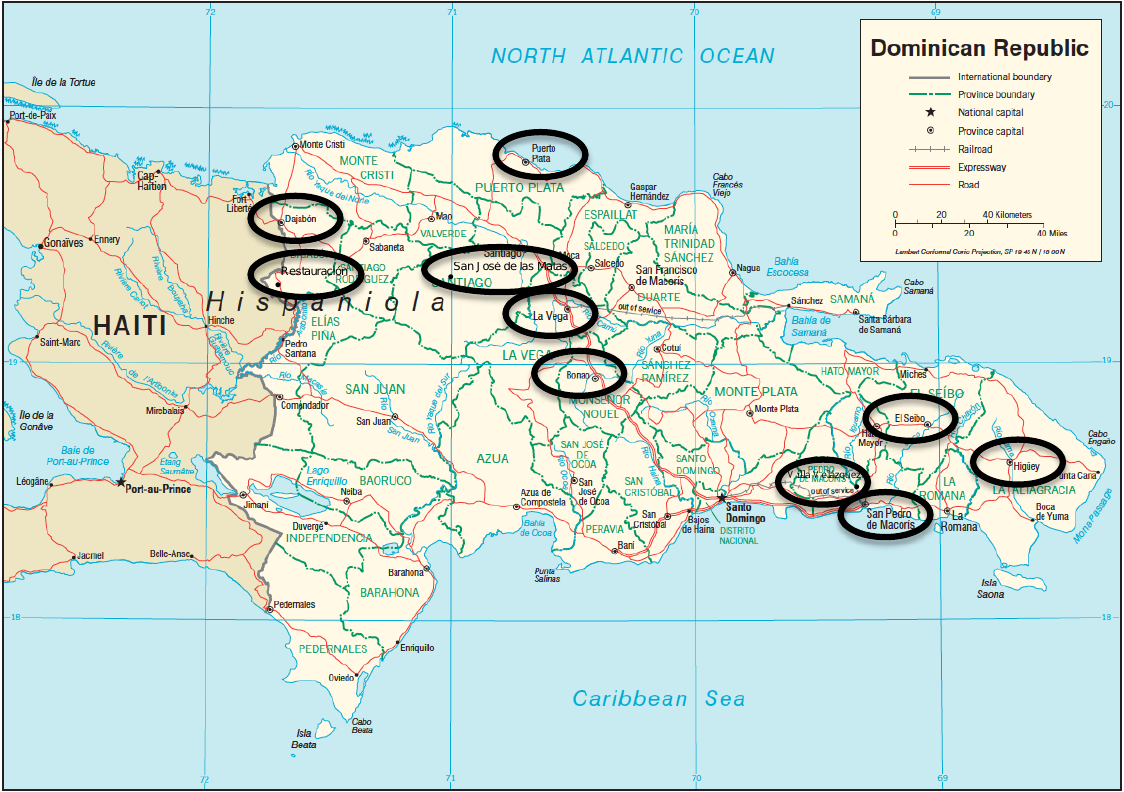
Figure (1): Location of the municipalities selected by Andrade (1930)